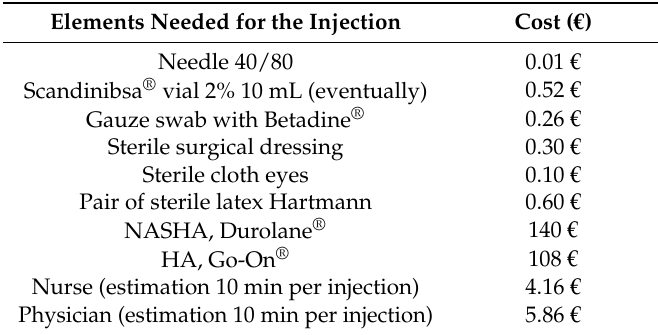
Table 1. Total cost for each injection.